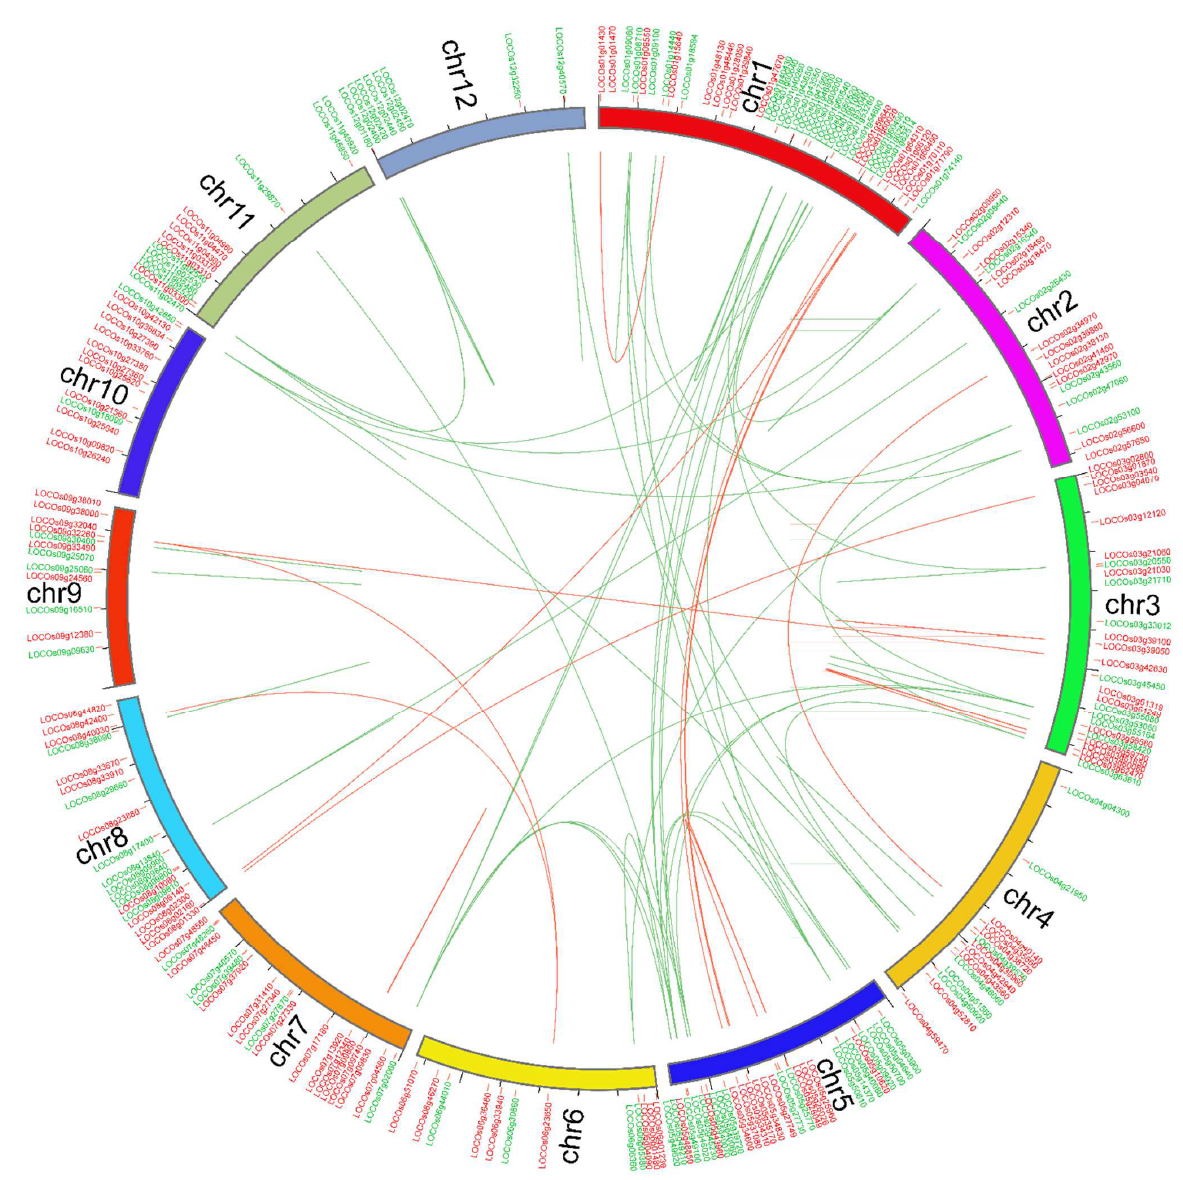
Figure 4. Chromosomal positions and inter-chromosomal groups of duplicated OsWRKY and OsNAC gene pairs were mapped on the twelve rice chromosomes (Chr1–Chr12). The green and red lines represent the segmental or tandem duplication network zones among WRKY and NAC genes, respectively.